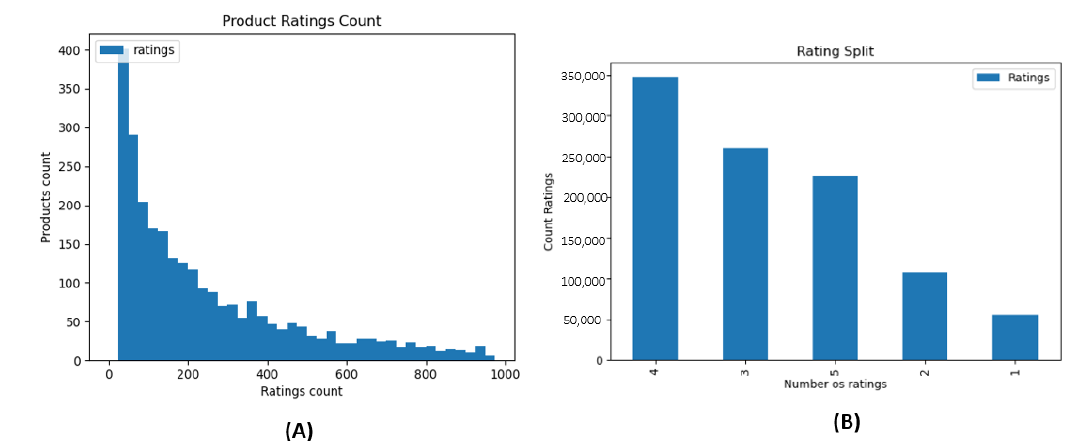
Figure 4. Distribution ratings of the ML-1M dataset: ( A ) Distribution of the quantity of products by a certain number of evaluations; ( B ) Total number of ratings for each scale value